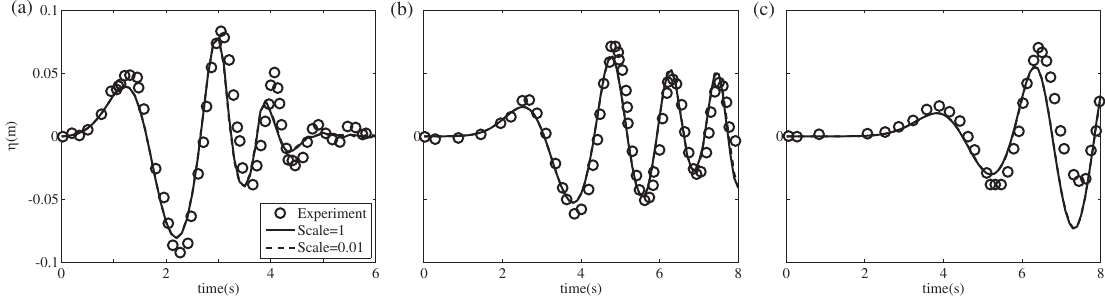
Figure 5. Wave gauges: Comparison between experimental and computed waves in the propagation field: ( a ) x = 4 m; ( b ) x = 8 m; and ( c ) x = 12